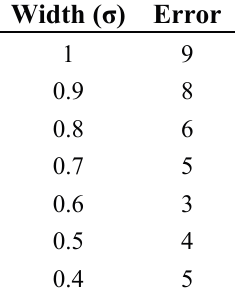
Figure 13. Performance criteria of SVM using 10-fold cross validation. Table 5. Misclassification errors obtained during support vector machine (SVM) classifier with different values of σ .